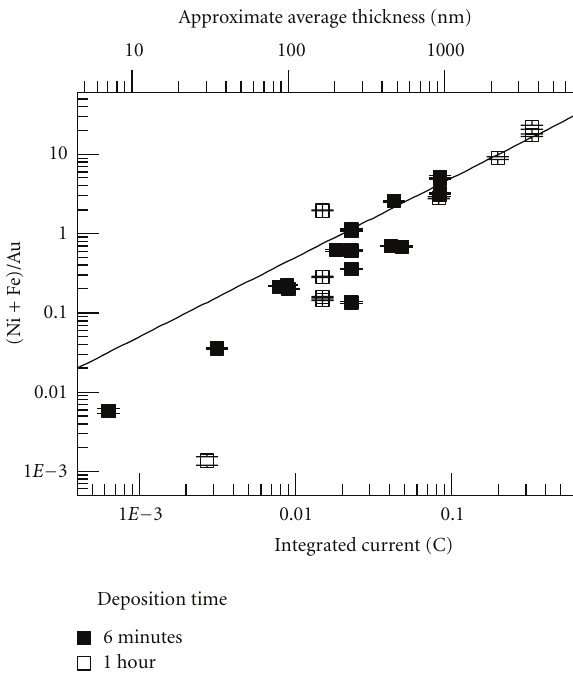
Figure 2: The (Ni + Fe)/Au ratio determined by PIXE as a func- tion of the integrated deposition current for all the samples. The deposition potentials varied from − 700mV to − 1200 mV and the deposition times were either 6 or 60min. The upper horizontal axis indicates an approximate average deposit thickness, calculated assuming 100% current e ffi ciency. The solid line with a slope of unity is a guide to the eye. The (Ni + Fe)/Au results fall below this line at lower integrated